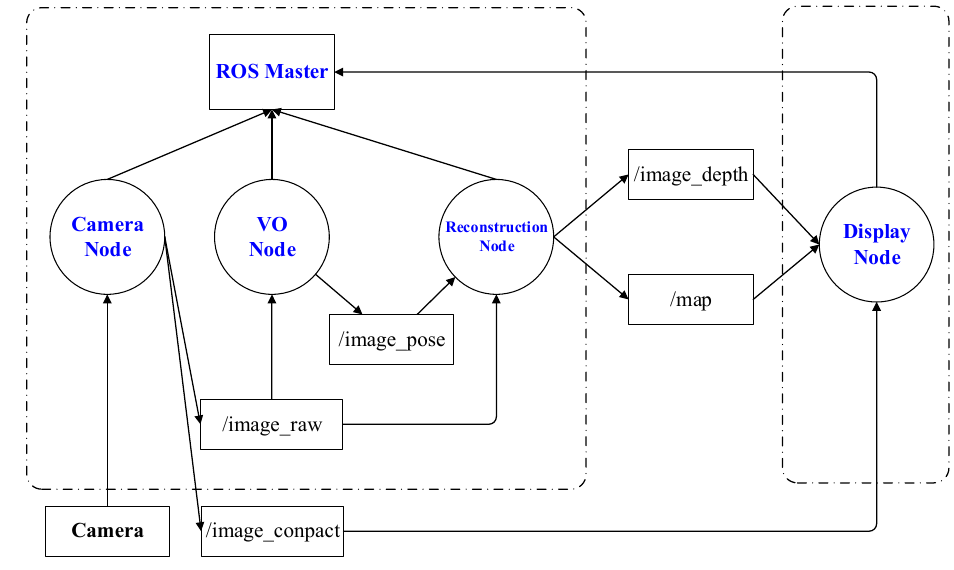
Figure 5. Functions and process nodes in this study.